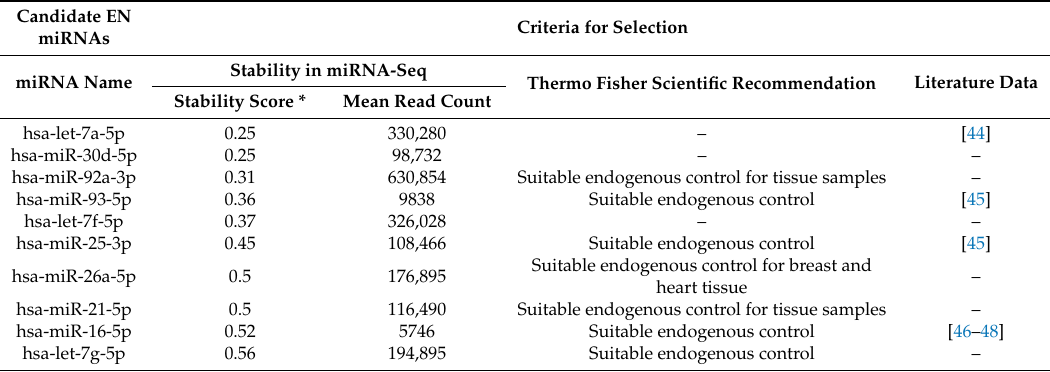
Table 1. Candidate endogenous normalizer miRNAs.